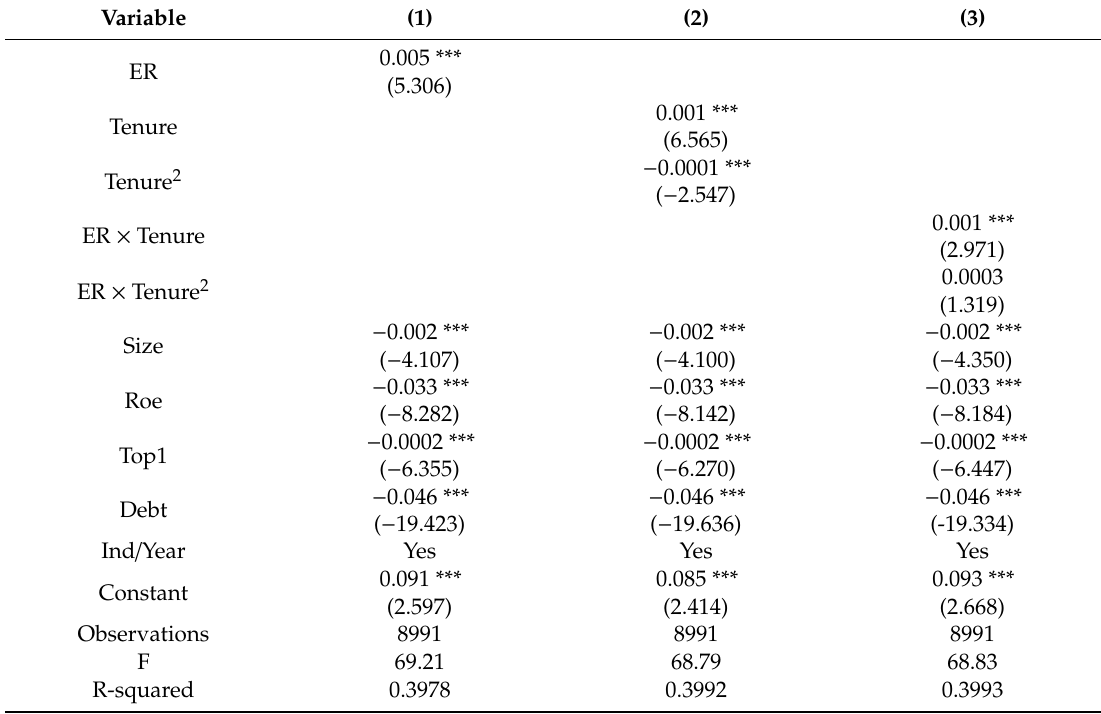
Table 6. Regression coe ffi cients for the robustness check